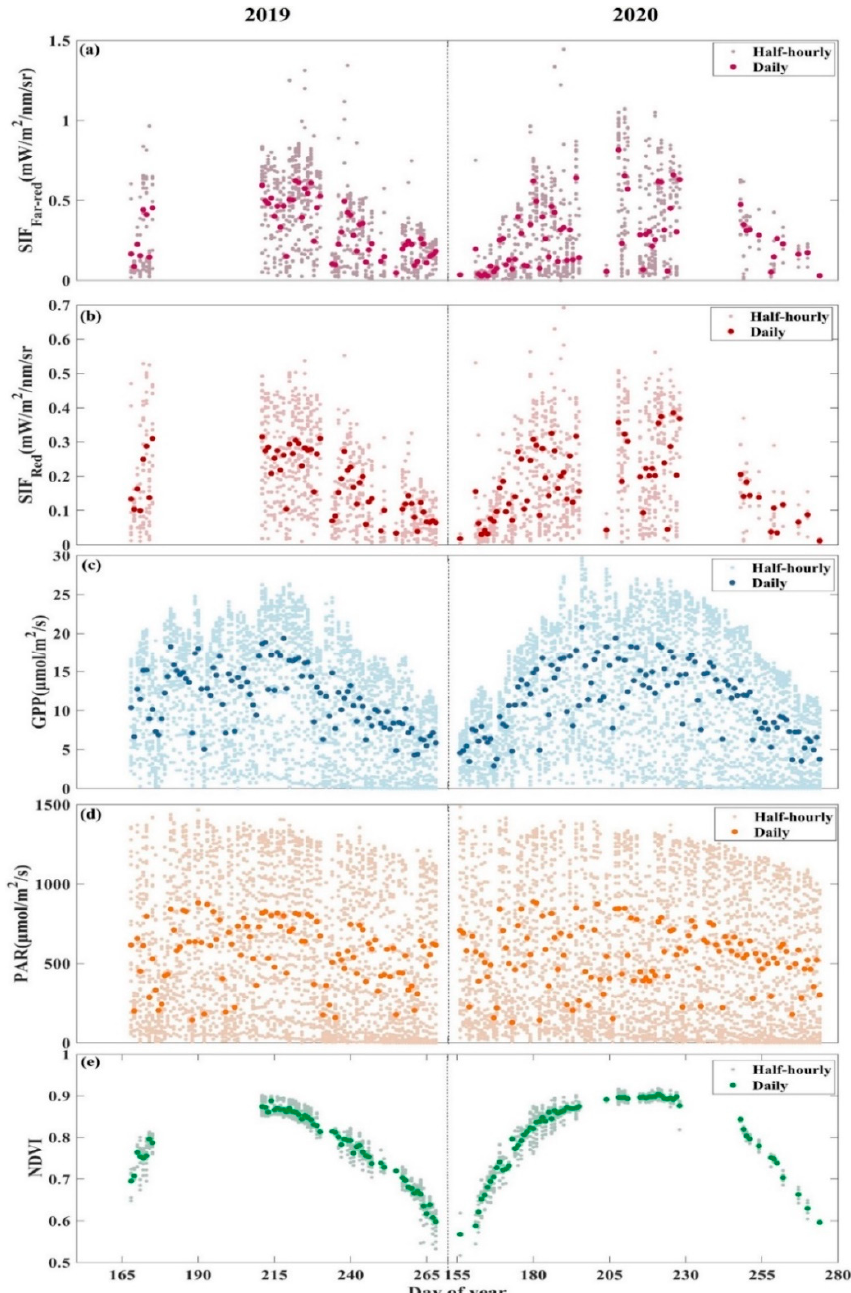
Figure 2. Seasonal patterns of ( a ) the canopy solar-induced chlorophyll fluorescence at the far-red band (SIF Far-red ), ( b ) the canopy solar-induced chlorophyll fluorescence at the red band (SIF Red ), ( c ) gross primary productivity (GPP), ( d ) photosynthetically active radiation (PAR), ( e ) normalized difference vegetation index (NDVI) at AR site in the growing seasons in 2019 ( left ) and 2020 ( right ). The dark large dots represent daily averaged data, and the light small dots represent half-hourly averaged